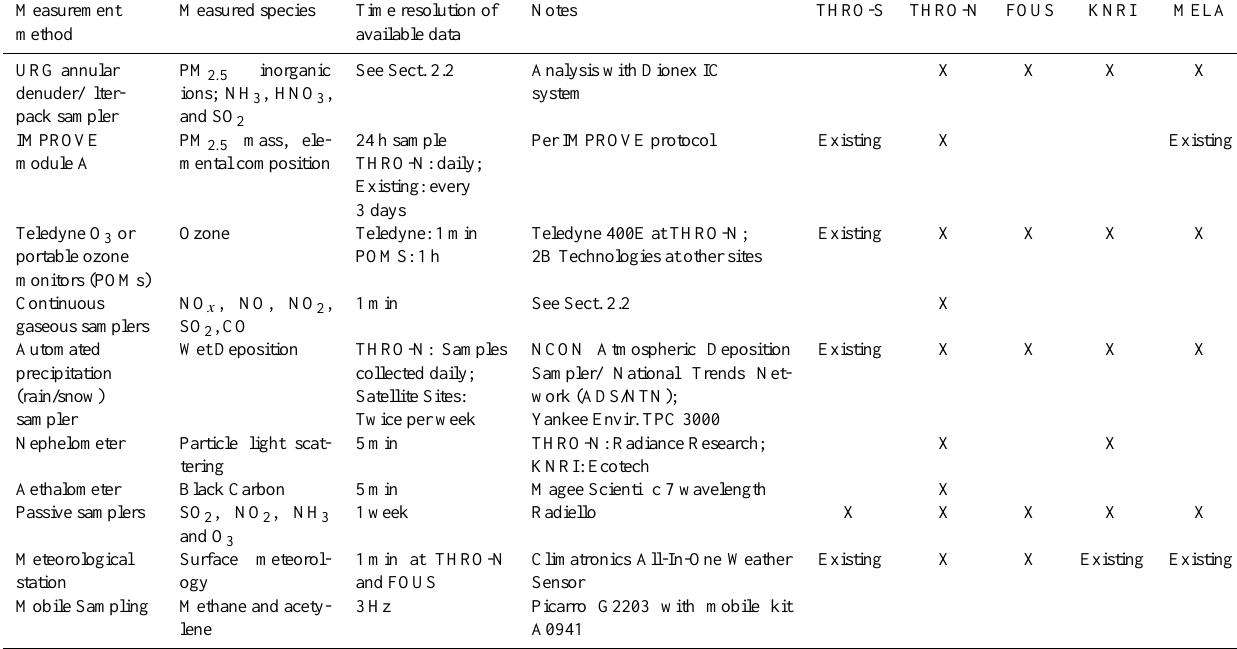
Table 1. Measurements from the first field campaign: 15 February–6 April 2013. Measurement